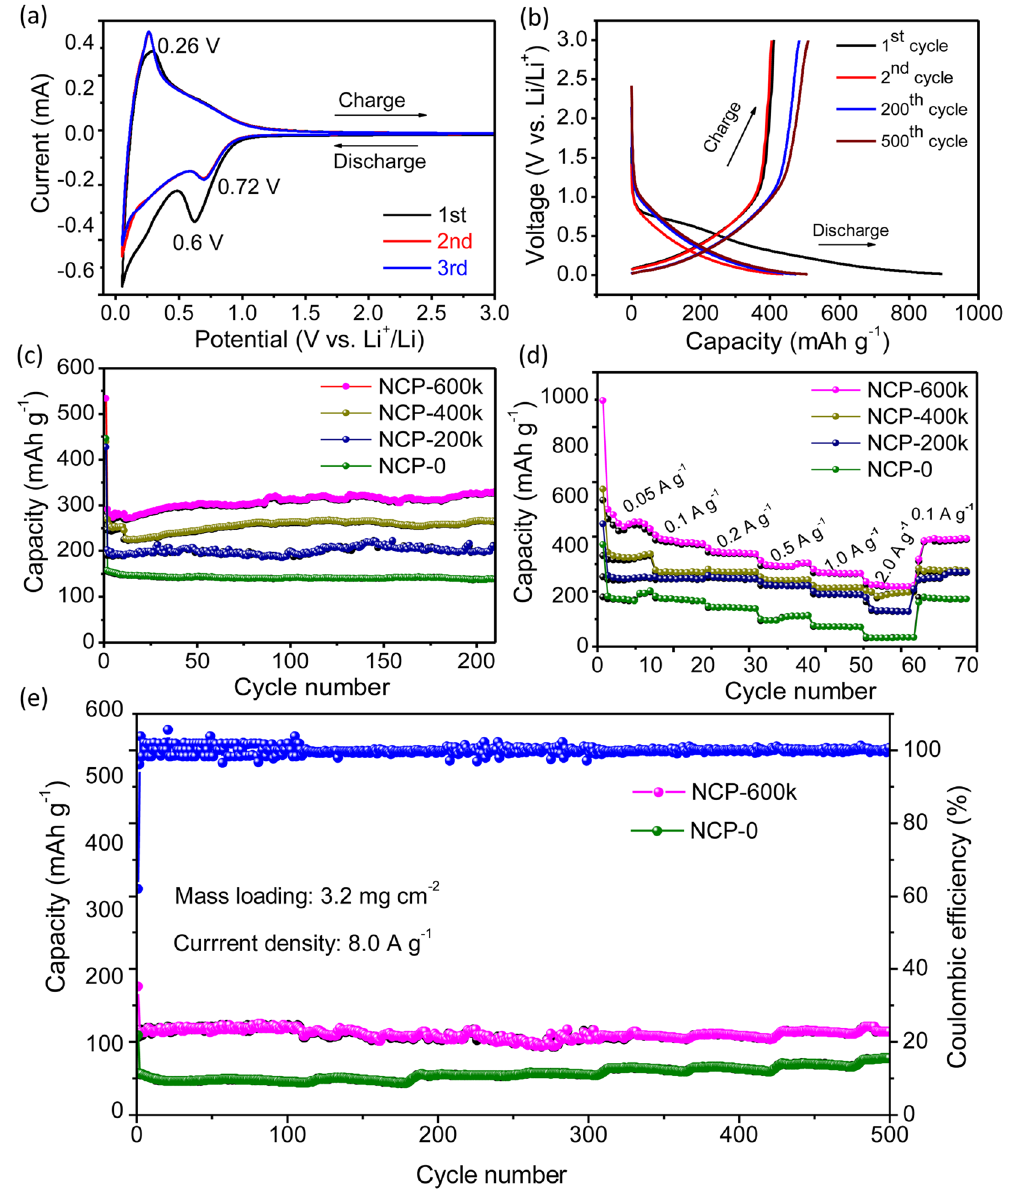
600k electrode at a current density of 0.05 A g − 1 ; ( c ) Cycling performance of the NCP electrodes at a current density of 0.5 A g − 1 ; ( d ) Rate capability of the NCP electrodes at different current densities; ( e ) Cycling performance of the NCP-0 and NCP-600k electrodes at a current density of 8.0 A g − 1 . For clarity, only the efficiency of NCP-600k is shown. The coulombic efficiency of NCP-0 is similar and close to 100% as